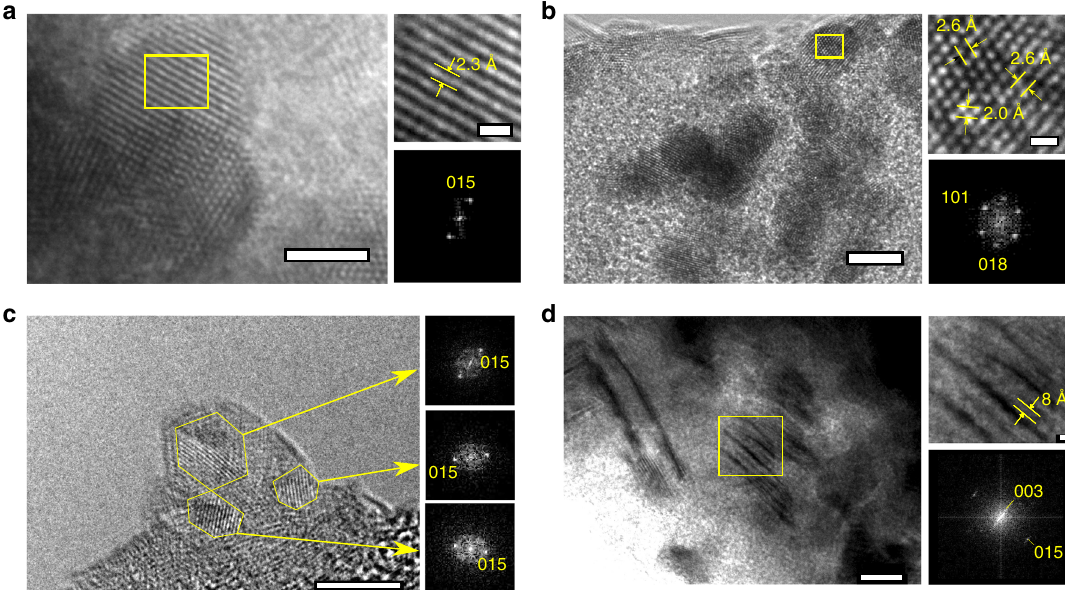
Fig. 3 HRTEM images of nanoplatelets. a Particles approximately 5 nm in diameter with high crystallinity on a SiO substrate, synthesized at 4.11 × 10 5 s − 1 (left). Highlighted crystalline domain (upper right) and corresponding Fourier transform (lower right) show lattice spacing of 0.23 nm, indicative of the (015) re fl ection. Scale bars are 2.5 nm (left) and 0.5 nm (upper right). b Uniform and crystalline particles synthesized at 4.11 × 10 5 s − 1 , approximately 5 nm in diameter aligned on a SiO substrate (left). Highlighted crystalline domain (upper right) and corresponding Fourier transform (lower right) show lattice spacings of 0.26 and 0.2 nm, indicative of the (101) and (018) re fl ections, respectively. Scale bars are 5 nm (left) and 0.5 nm (upper right). c A nanoplatelet 7 nm in diameter synthesized at 3.16 × 10 6 s − 1 (left). Fourier transforms of the outlined crystal domains (upper, middle, and lower right) indicate variation in the position of the (015) peak and crystallographic orientation. Scale bar is 5 nm (left). d Mesocrystalline structure in a large aggregate (left), with highlighted crystalline domain (upper right). Scale bars are 10 nm (left) and 1 nm (upper right). Interlayer stacking between particles is approximately 0.8 nm, indicative of the (003) plane. Corresponding Fourier transform (lower right) also shows a peak indicative of the (015)